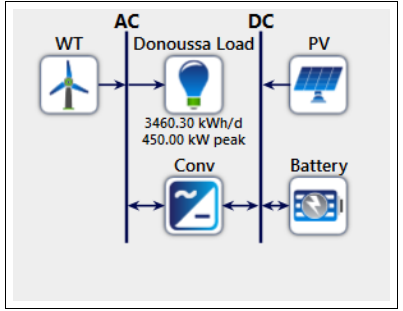
Figure 7. Scenario 3 Homer Pro